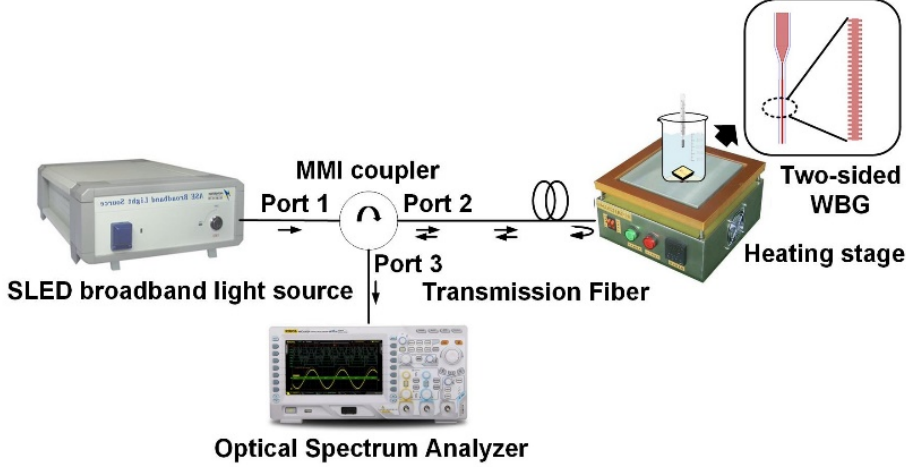
Figure 6. Schematic of two-sided WBG temperature sensor experimental system.